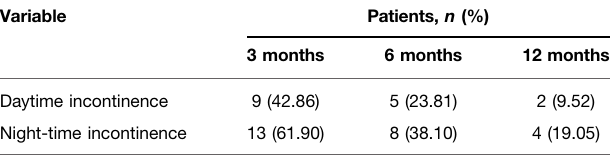
TABLE 5 | Functional